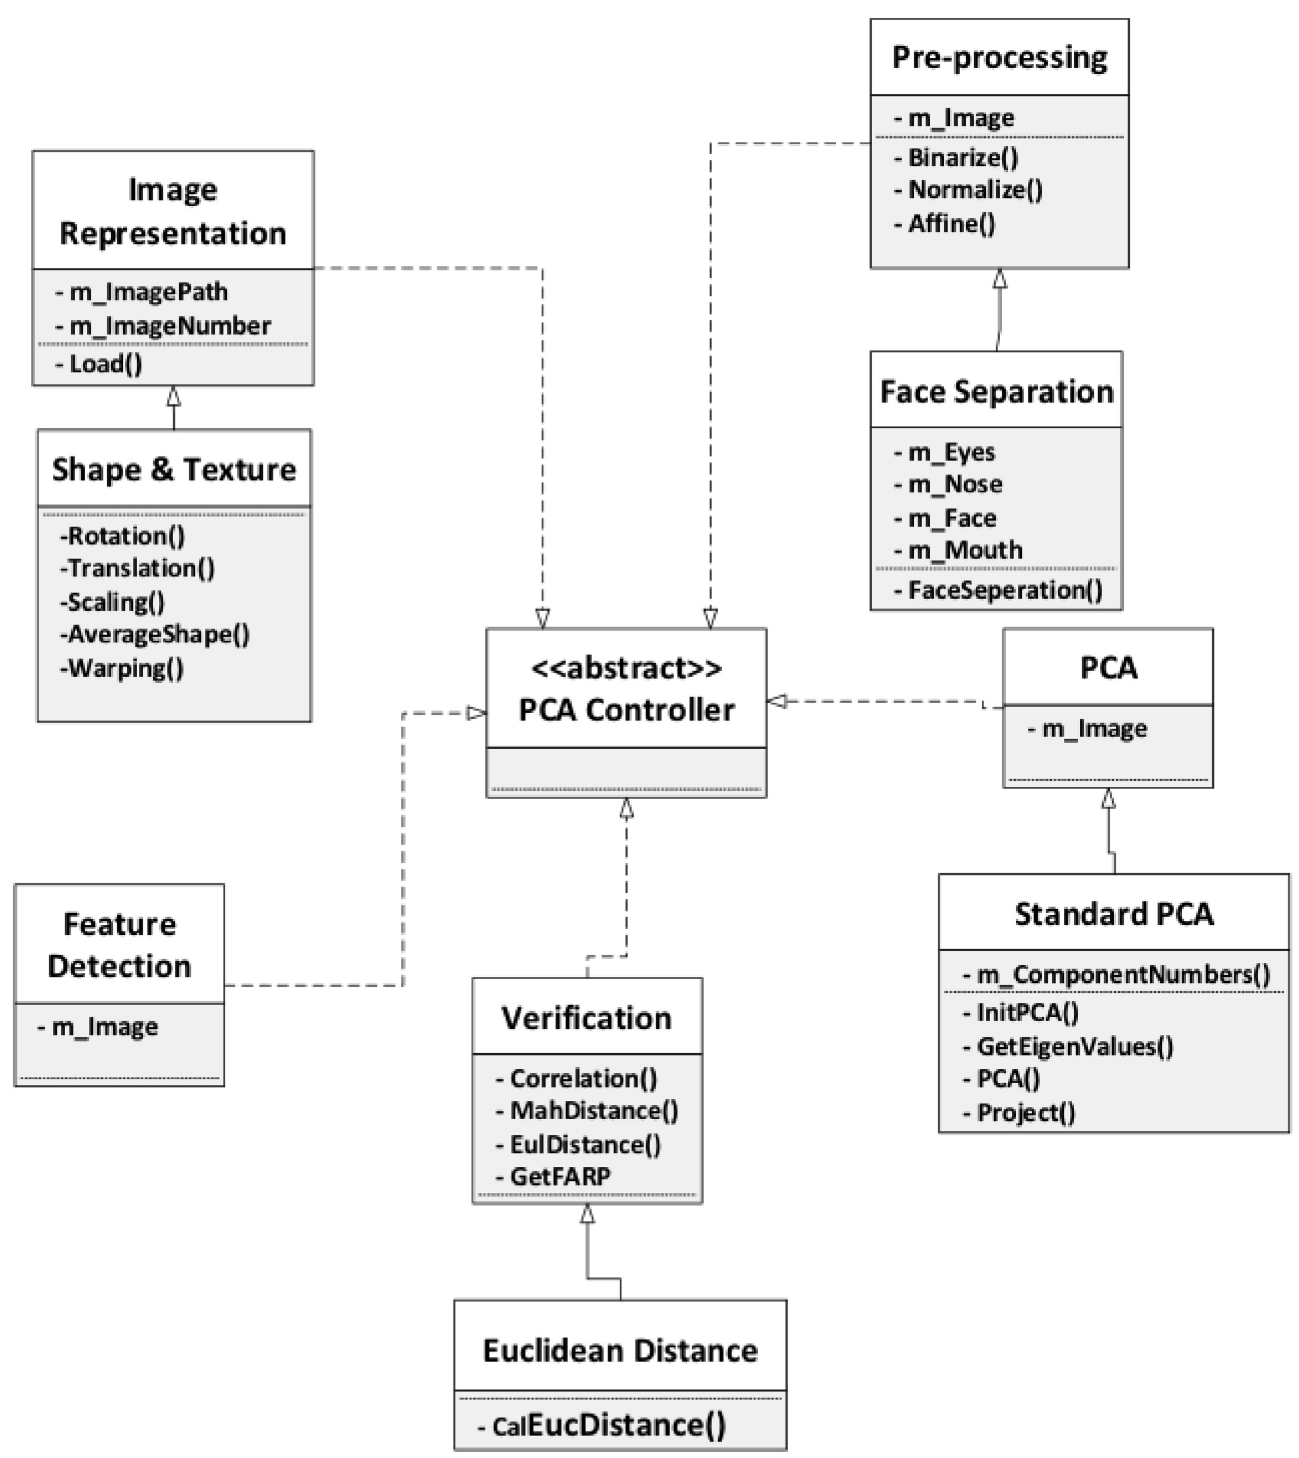
Fig 30. Case Study